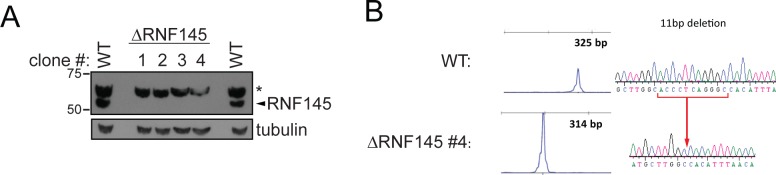
Validation of RNF145 knockout clones.(A) Immunoblot for RNF145 in HeLa WT vs. four RNF145 knockout (ΔRNF145) clones, generated with two independent sgRNAs. Non-specific bands are indicated (*). (B) Genetic validation of RNF145 knockout clone #4 (ΔRNF145 #4). The genomic region surrounding the predicted sgRNA annealing site was amplified using fluorescent primers and amplicon size determined by capillary electrophoresis (Agilent Bioanalyzer 2100). Fluorescent traces are shown alongside amplicon sequences as obtained by Sanger sequencing, confirming an 11 base pair deletion (indicated).